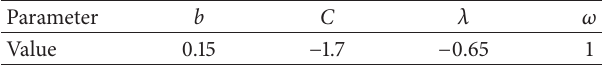
Table 1: System parameters